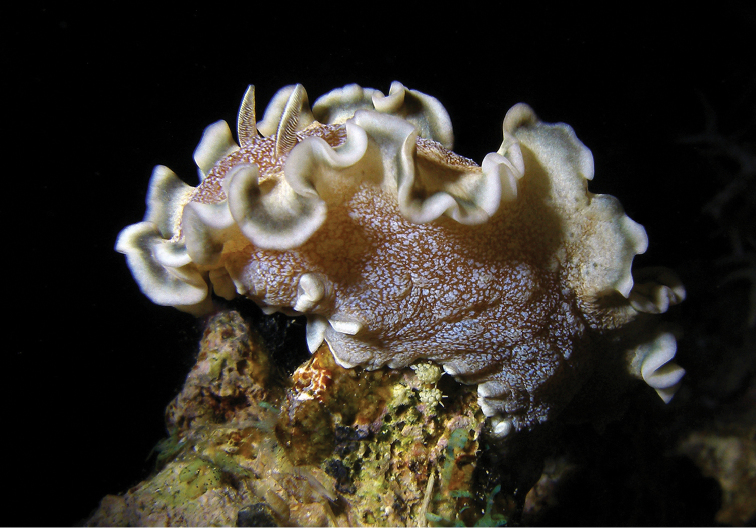

Glossodoris
hikuerensis (Pruvot-Fol, 1954), photograph S Kahlbrock.